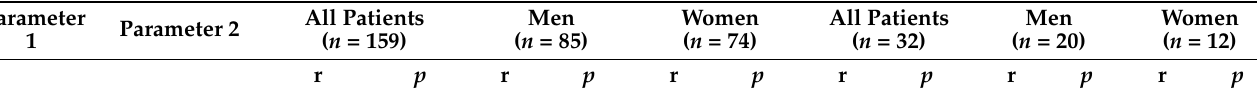
Table 14. Correlations in patients with